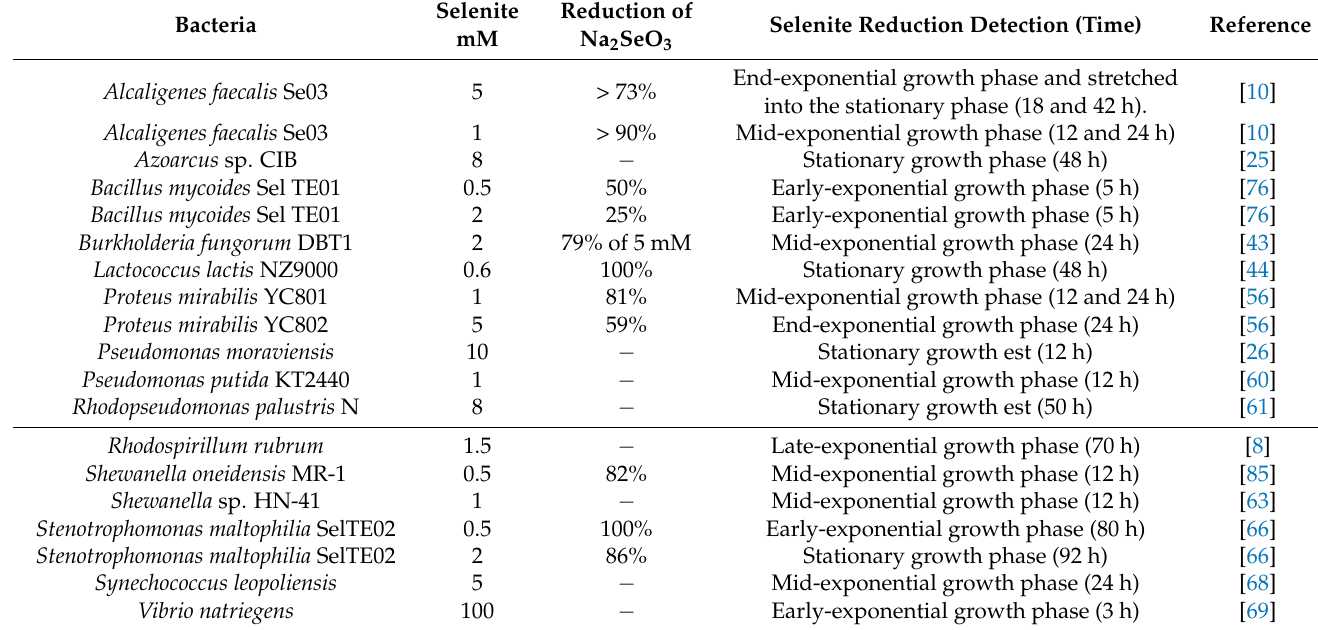
Table 2. Selenite reduction detection in the growth